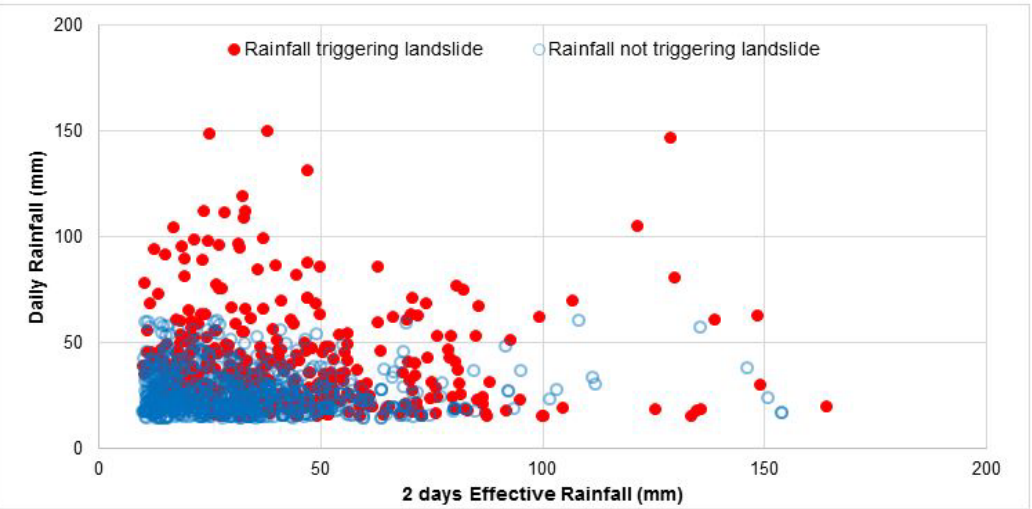
Figure 4. Relationship between 2-day effective antecedent rainfall and daily rainfall that triggered and did not trigger landslides from 2017 to